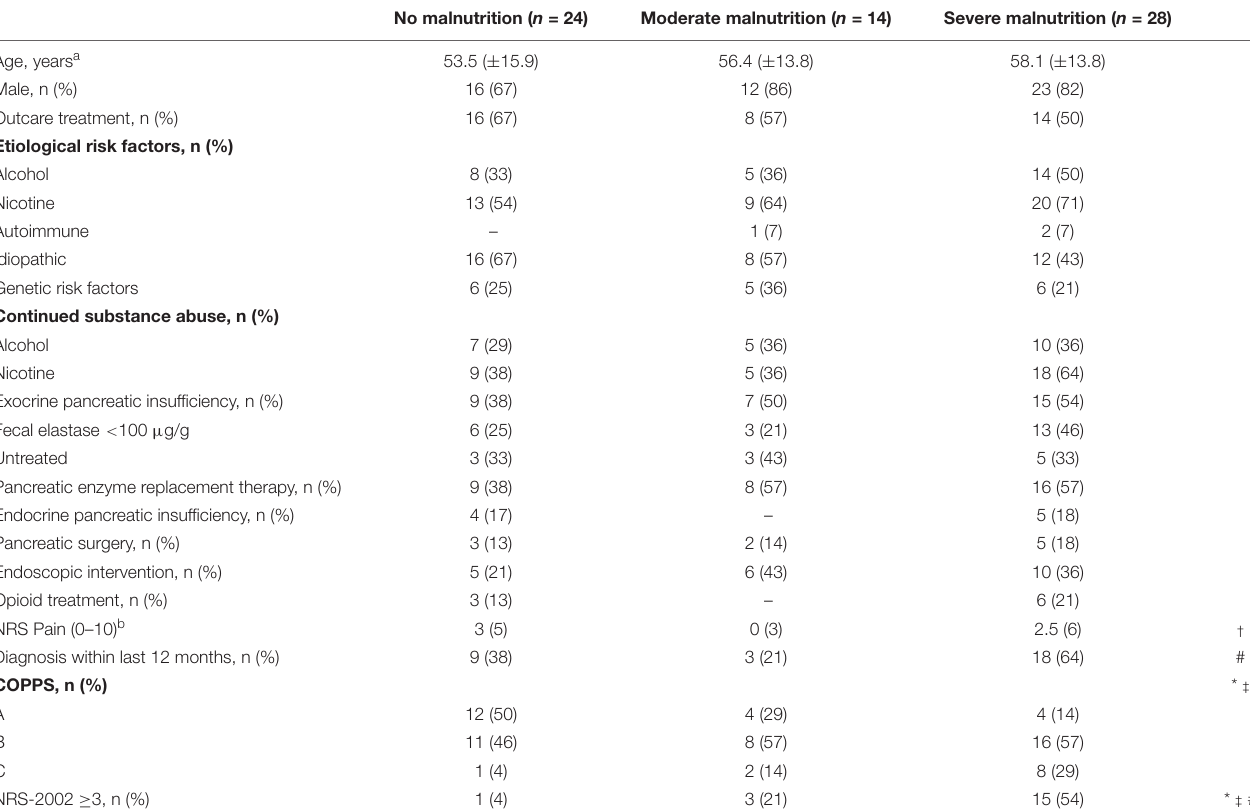
TABLE 1 | Demographic and clinical characteristics of patients with chronic pancreatitis stratified by nutritional status. No malnutrition ( n = 24) Moderate malnutrition ( n =